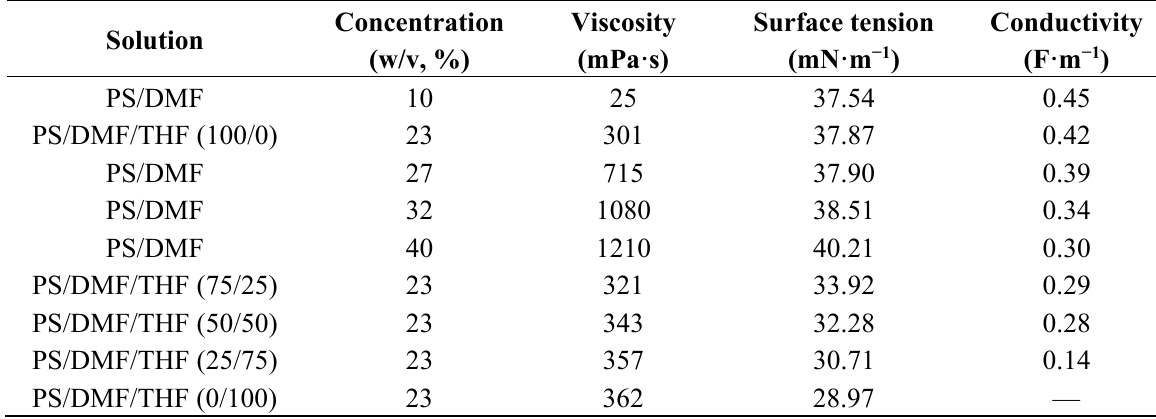
Table 2. Characteristic properties of tested solutions a